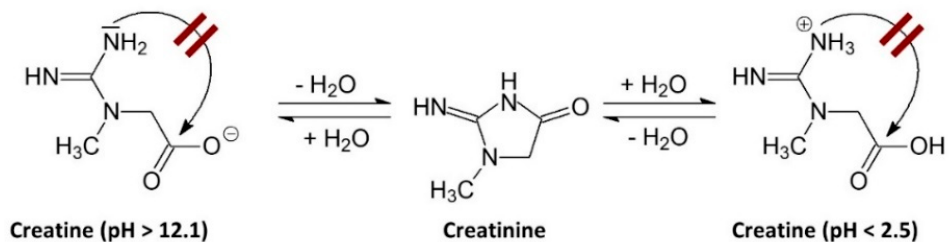
Figure 5. Influence of pH on creatine stability in solution.